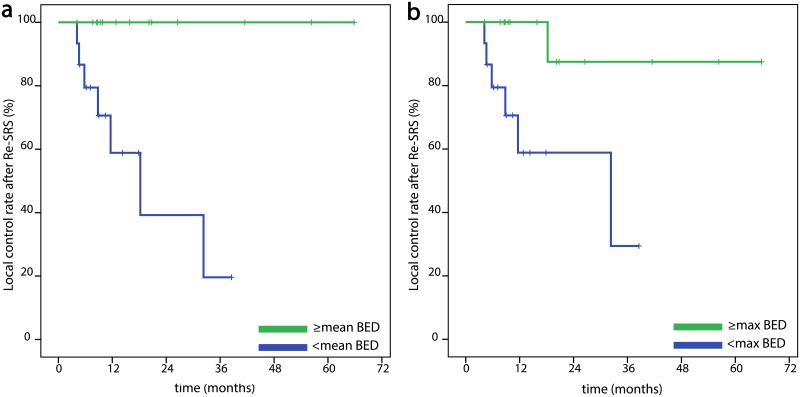
Kaplan-Meier curves of local control rate after Re-SRS.a) dependent on BEDmean (≥ median vs. lower) b) dependent on BEDmax (≥ median vs. lower).